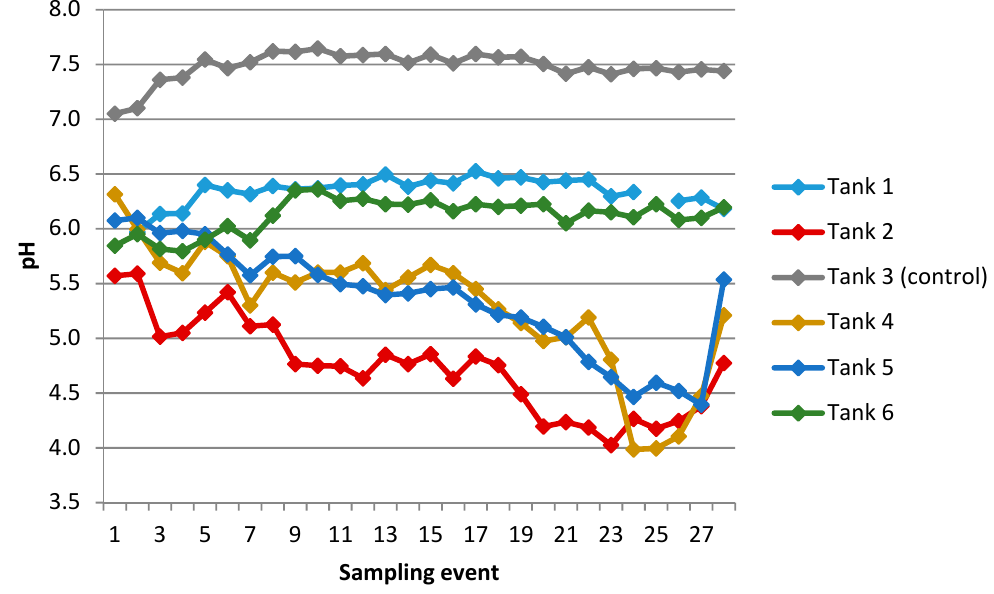
Figure 8. Changes in pH in water sampled from each tank over 28 sampling events.